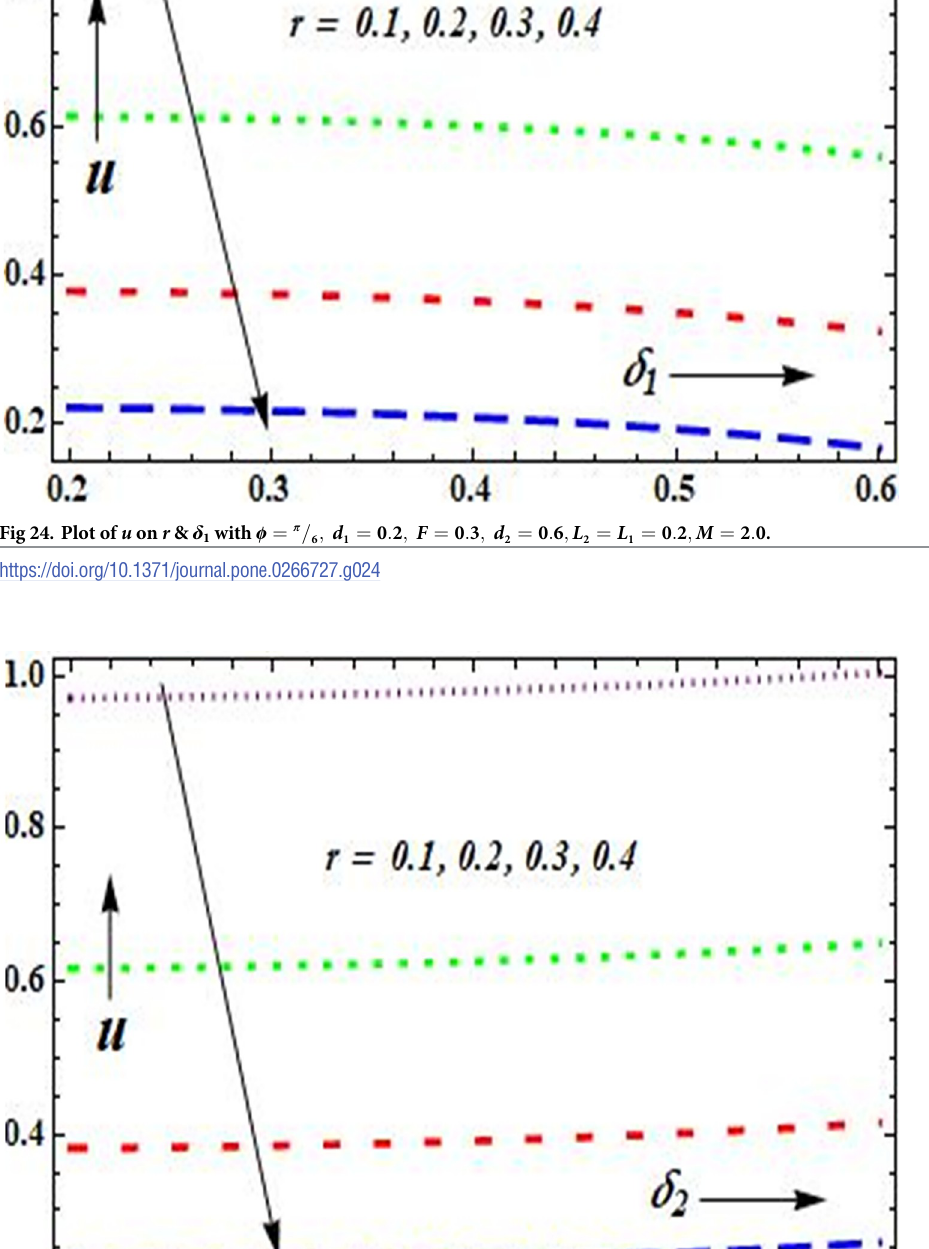
; d ¼ 0 : 2 ; F ¼ 0 : 3 ; d 1 6